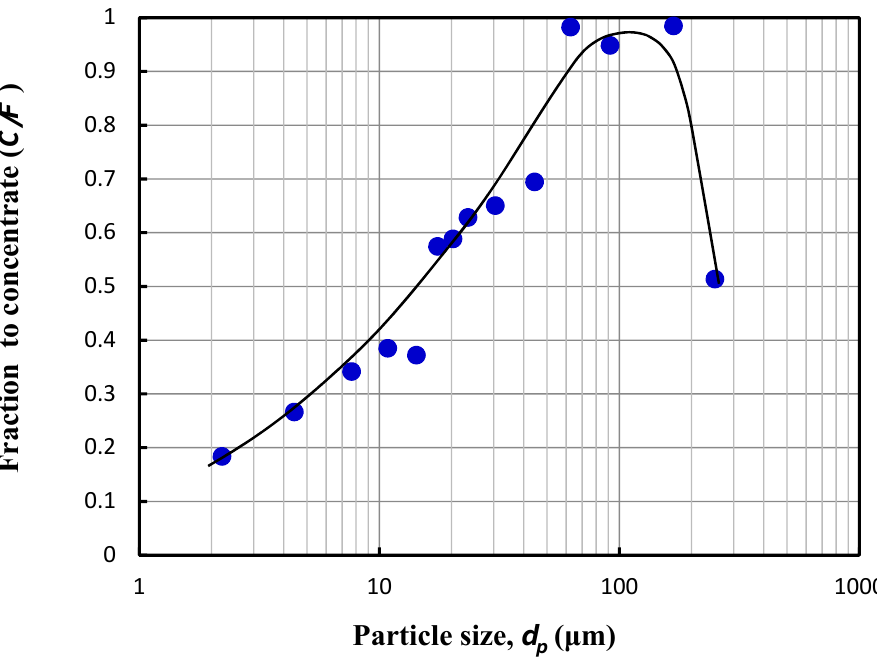
Figure 2. Performance curve as fraction to concentrate ( C / F ) vs. particle size ( 𝑑 (cid:3043) ).